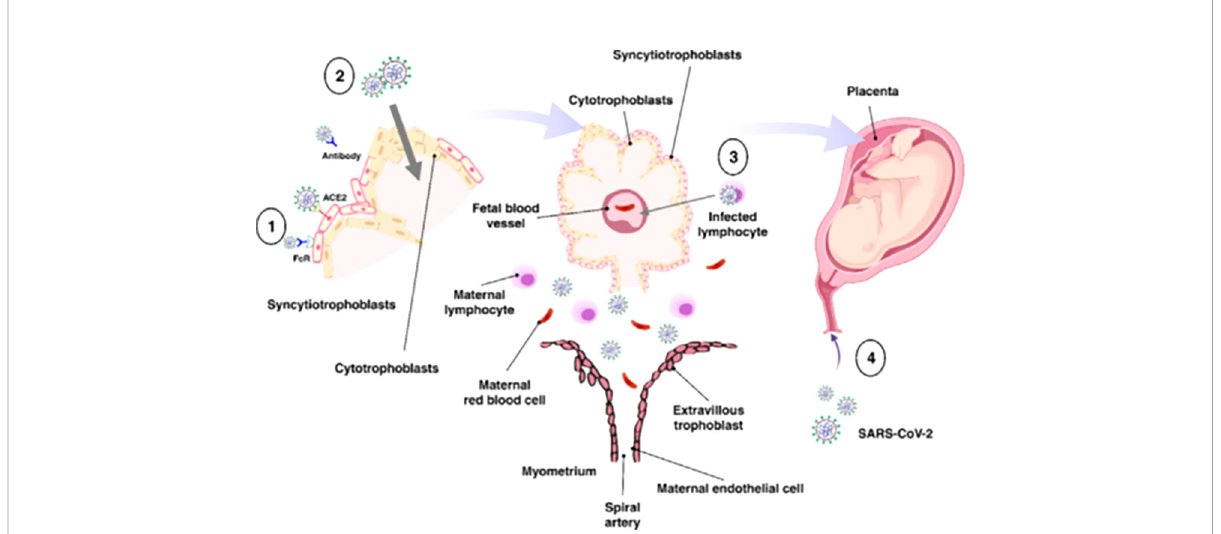
FIGURE 3 Possible mechanisms of transplacental transmission. There are several potential mechanisms involved in the virus ’ s vertical transmission from mother to fetus. (1) Infection caused by direct villous tree damage. (2) Infection through the maternal endothelium to the extravillous trophoblast. (3) Infection caused by maternal immune cell traf fi cking and transcellular transport. (4) Infection through the vagina. Adapted from